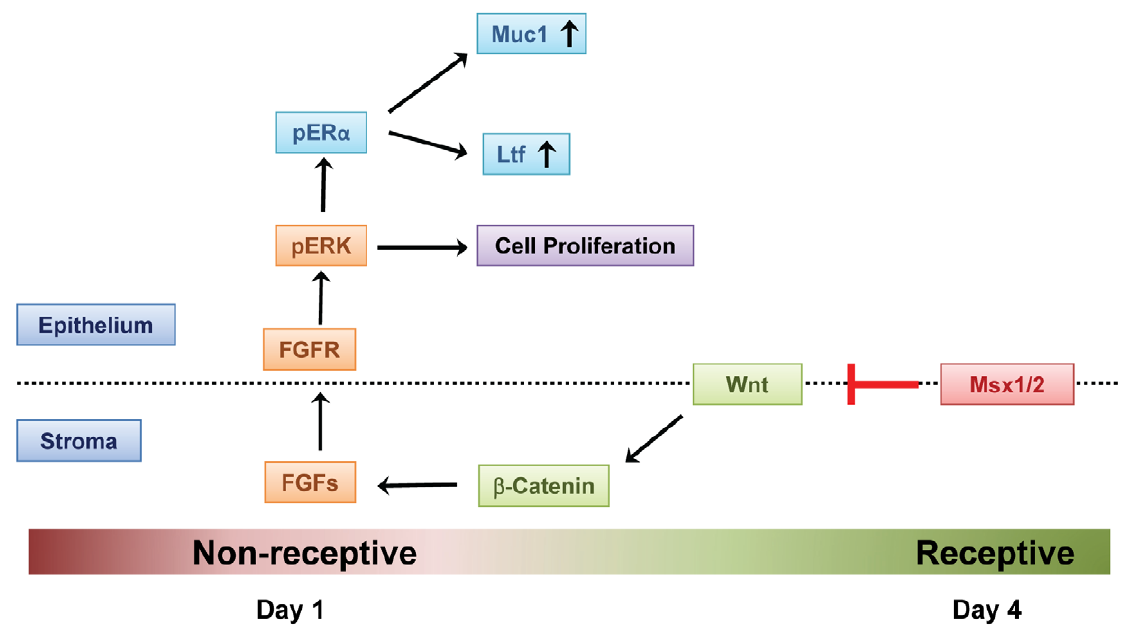
Figure 7. Mechanism of Msx1 and Msx2 action in mouse uterus. In normal pregnancy, MSX1 and MSX2 act to repress WNT and b -catenin signaling and inhibit FGF synthesis in the uterine stroma, thereby suppressing stromal-epithelial cross-talk. In the absence of MSX1 and MSX2, FGFs are induced, activating the epithelial FGFR-ERK1/2 pathway, and promoting epithelial proliferation. Activated ERK1/2 then phosphorylates epithelial ESR1. This triggers transcriptional activation of ESR1 and expression of its target genes, such as Muc-1 , which prevent the functional transformation of the luminal epithelium to receptive state, blocking embryo implantation.